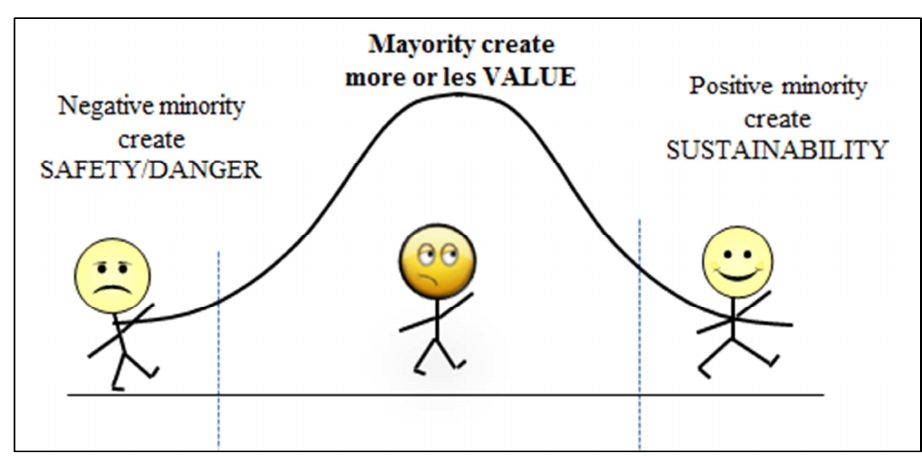
Diagram 2 – Three different qualities related to gauss distribution (Kiauta,